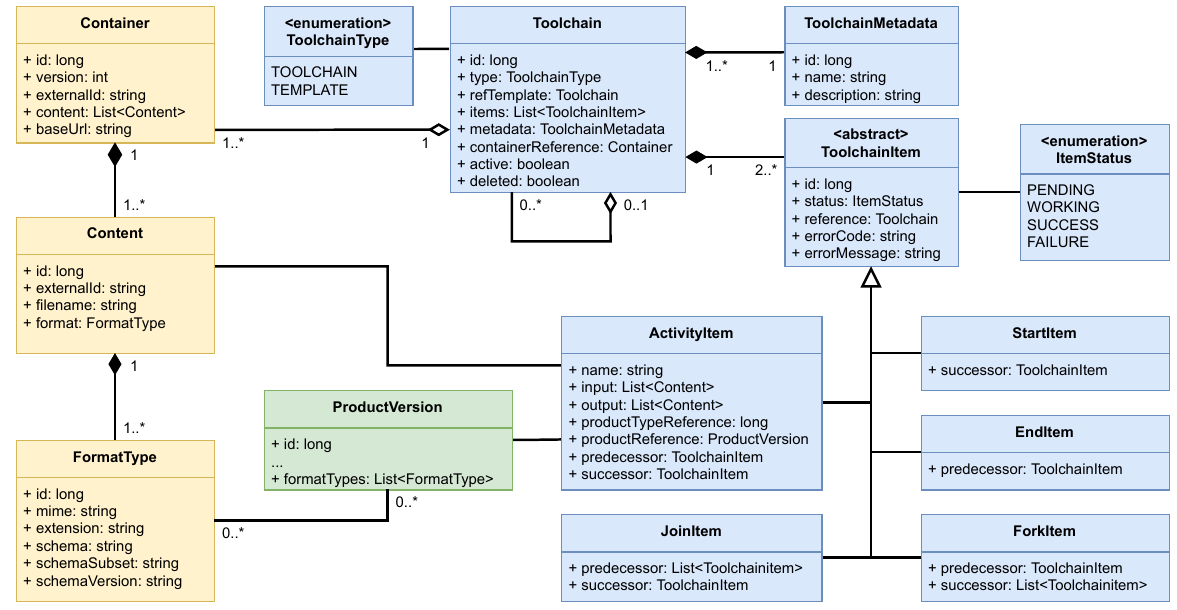
Figure 4. Toolchain UML data model providing toolchain and process flow objects (blue), data flow objects (yellow), and product information objects (green) and their relations. The star character (*) is used as part of a multiplicity specification to represent an unlimited upper